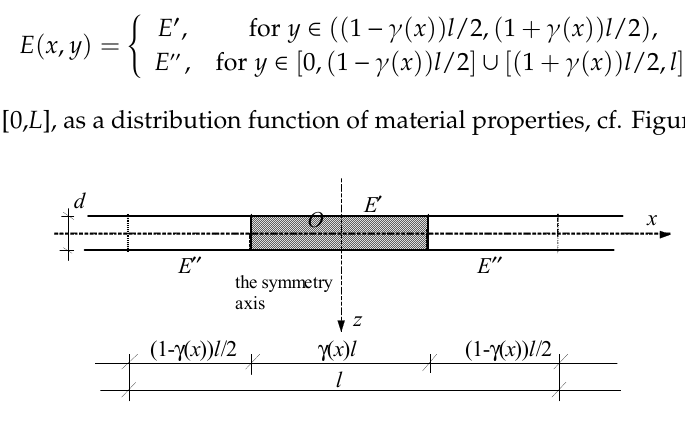
Figure 2. A part of a microstructured functionally graded plate band.